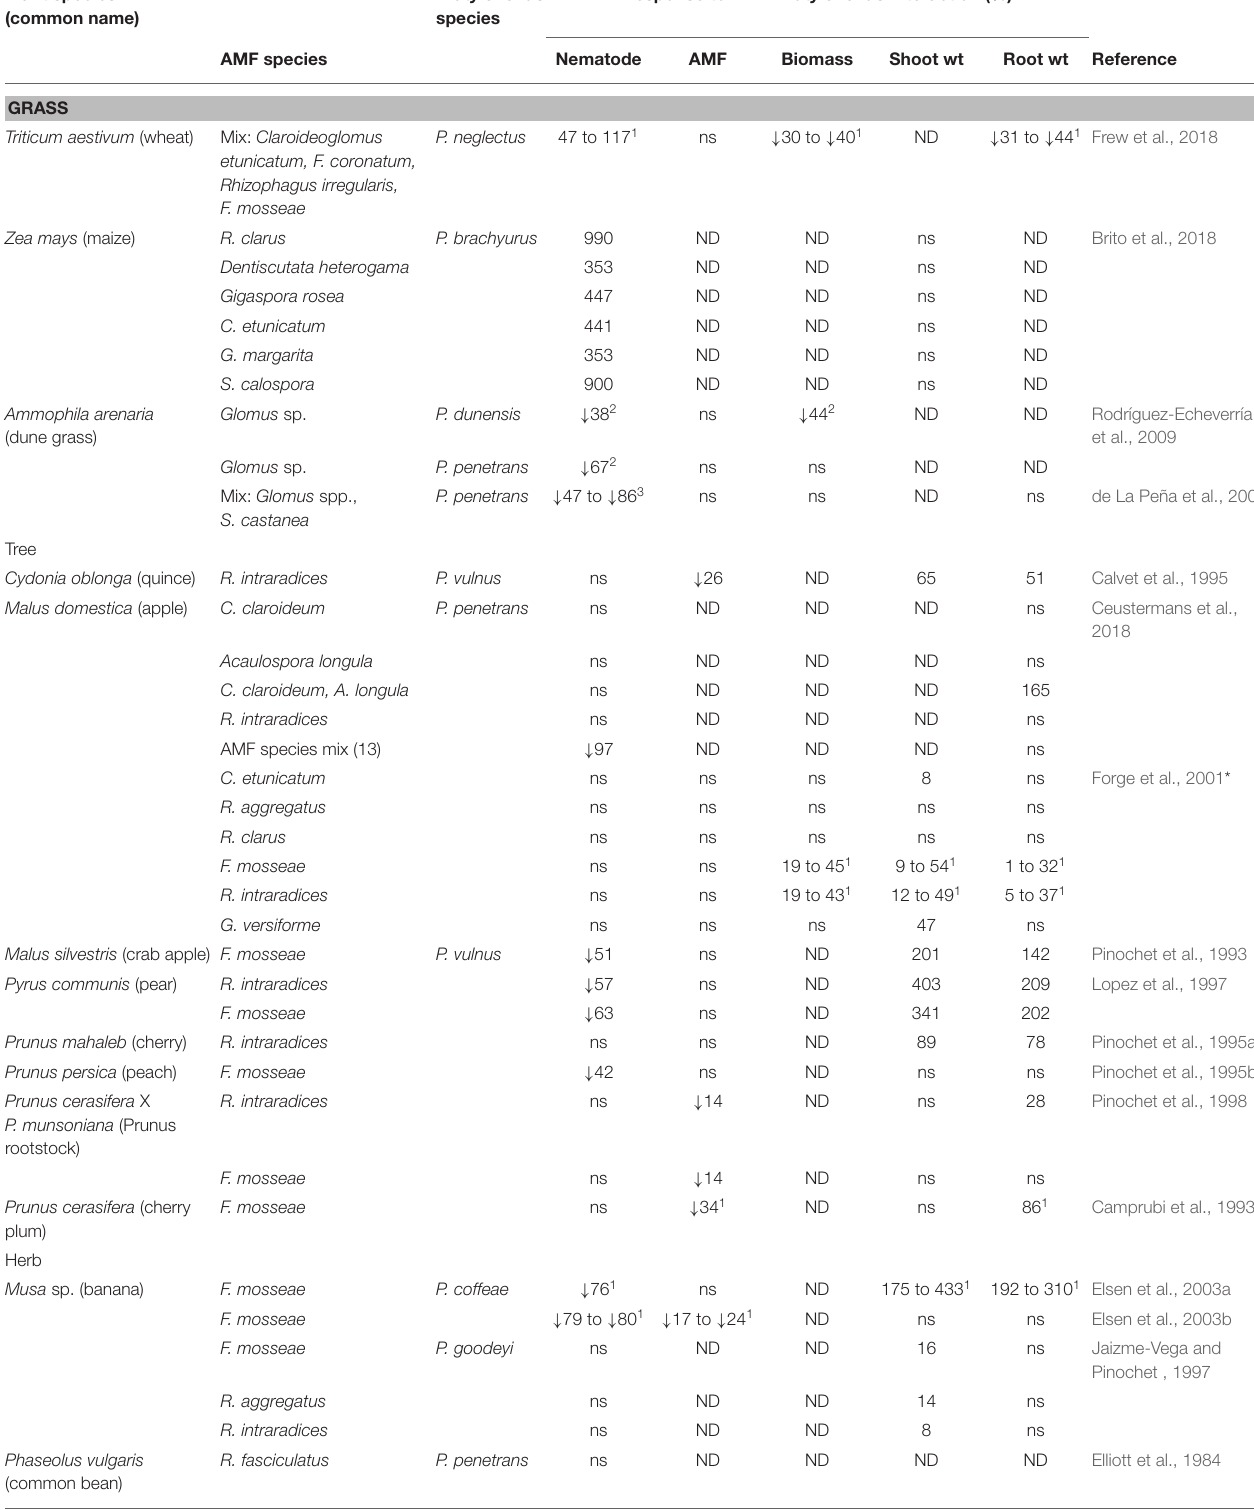
TABLE 3 | Response of Pratylenchus spp., arbuscular mycorrhizal fungi (AMF) and plants to co-inoculation of AMF and Pratylenchus spp. compared to Pratylenchus sp. alone in glasshouse and microplot experiments. Plant species (common